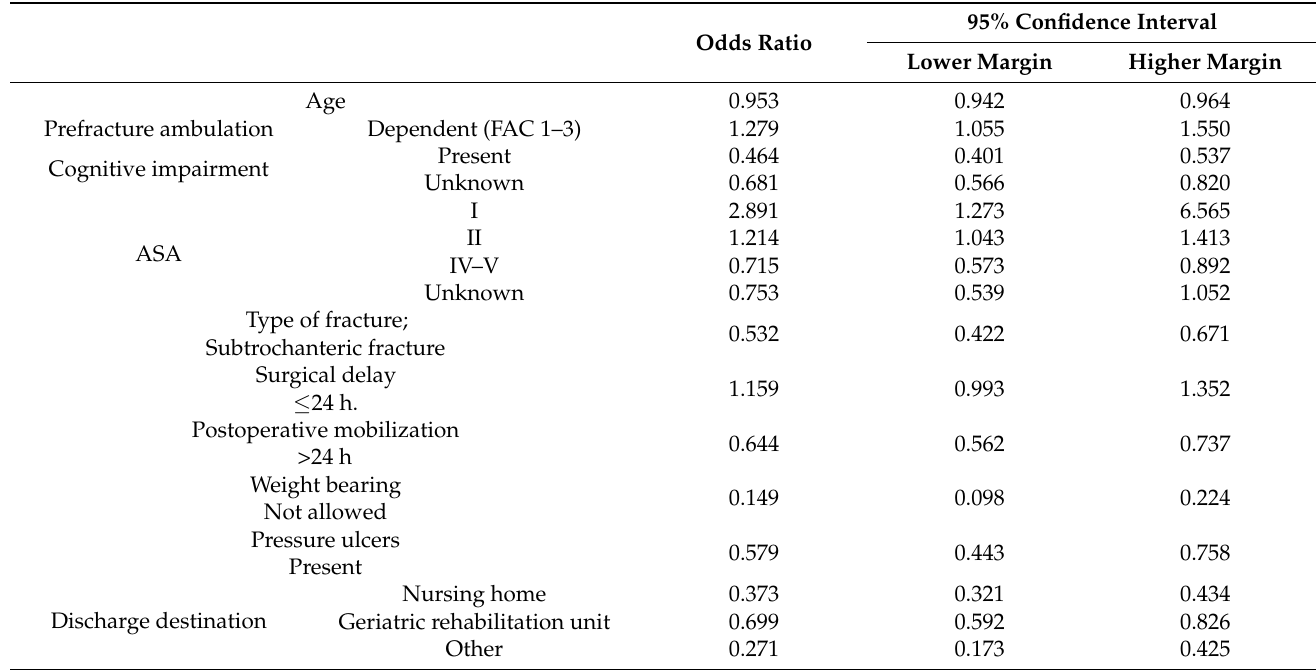
Figure 2. Equation of the logistic regression model. Note that in the model some variables appear several times; this is because each time it refers to one of the variable’s categories. Thus, for exam- ple, the ASA variable has 5 categories: reference (ASA III), I, II, IV-V and unknown. ASA III level will be ASA II = 1 and the rest of the ASA levels will be = 0. Table 3. Results of the logistic regression model. Odds ratios of the explanatory variables, with the target variable “recov- ery of ambulation”.